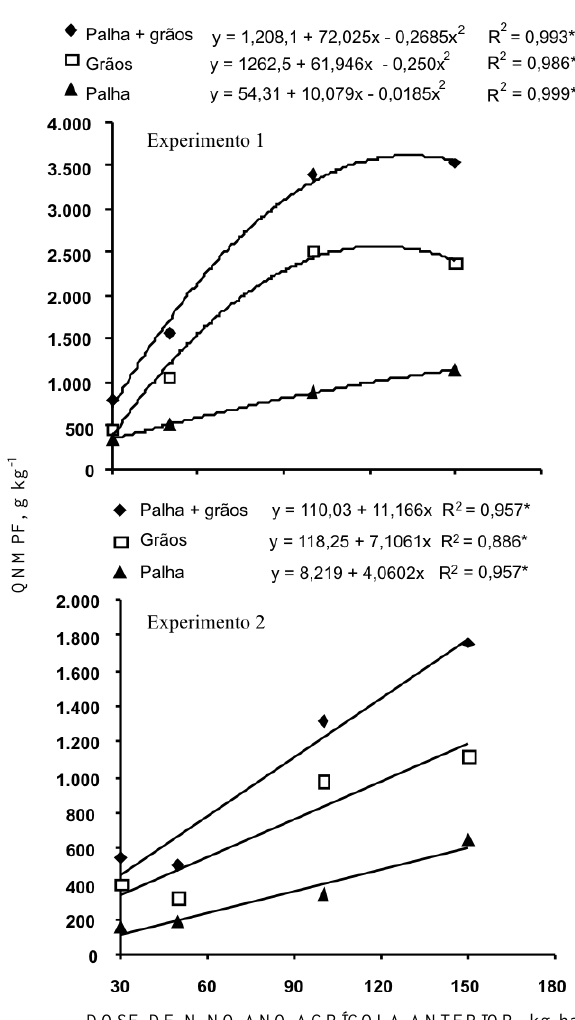
Figura 2. Quantidade de N residual da uréia no milho (palha, grãos e palha + grãos) (QNMPF) em 2002/ 03 (experimento 1) e 2003/04 (experimento 2), considerando a dose de N aplicada ao milho no ano agrícola antecedente.